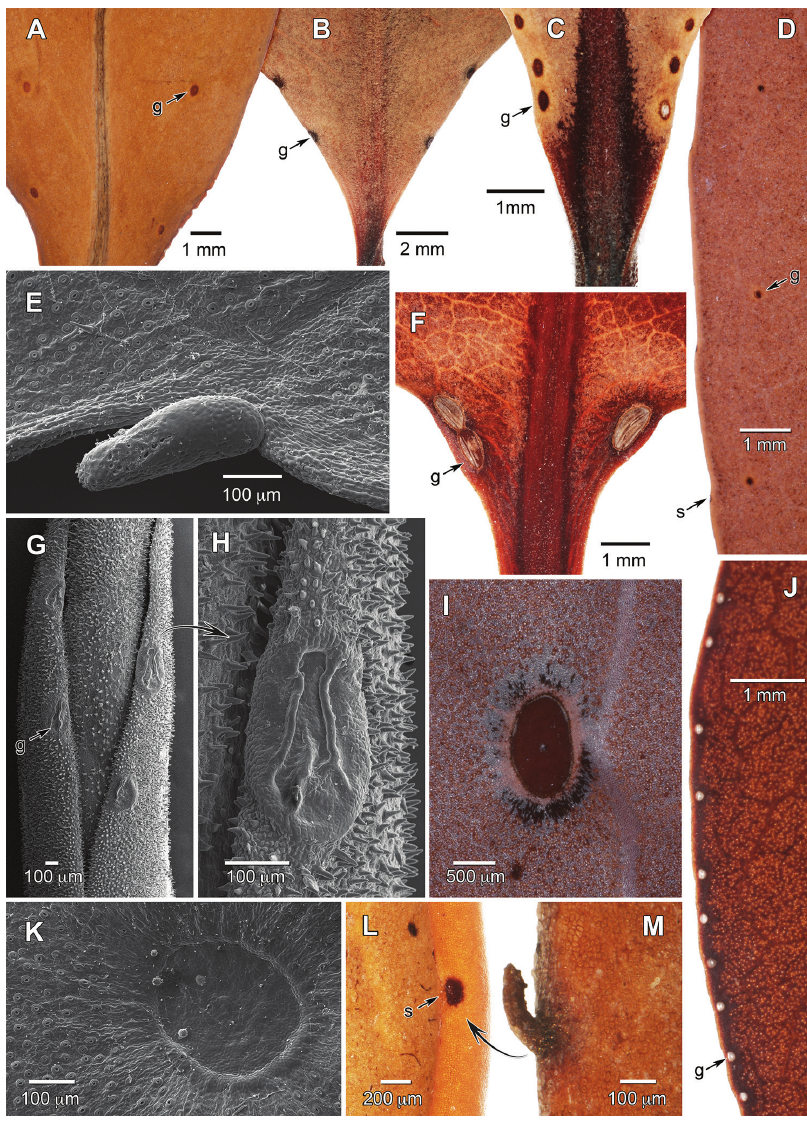
Figure 4 . Extrafloral nectary and leaf margin diversity of Humiriaceae. A Vantanea depleta laminar glands, abaxial B Duckesia liesneri basilaminar glands, adaxial C Schistostemon oblongifolius basilaminar glands, adaxial D Humiriastrum ottohuberi laminar glands, abaxial E Duckesia verrucosa robust seta at mar- gin F Sacoglottis guianensis basilaminar glands, adaxial G Humiria fruticosa shoot tip with marginal glands exposed on expanding new leaf H Humiria fruticosa marginal gland I Hylocarpa heterocarpa laminar gland, abaxial J Humiria balsamifera var. minarum dense row of marginal glands, abaxial K Duckesia verrucosa laminar gland, abaxial L Schistostemon retusus darkened scar from deciduous seta M Schistostemon retusus intact seta at margin. g = gland, s = seta scar. Sources: A Mori & Kallunki 4889 B Liesner 22589 C Maas et al. 6804 D Maguire 34912 E, K Ducke 2108 F Jansen-Jacobs et al. 1898 G, H Steyermark 103255 I Ducke [JBRJ-30137] J Mexia 5815 L Redden 3372 M Cuatrecasas 7203 (all